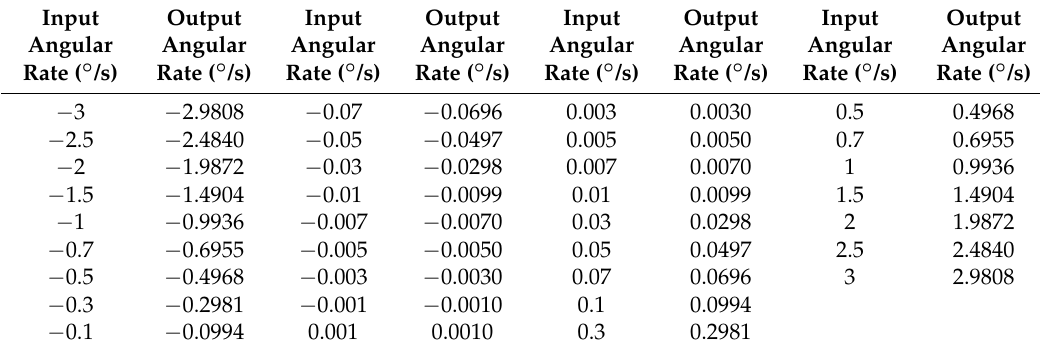
Table 2. HRG output for 1μm–0° uneven capacitance gap.